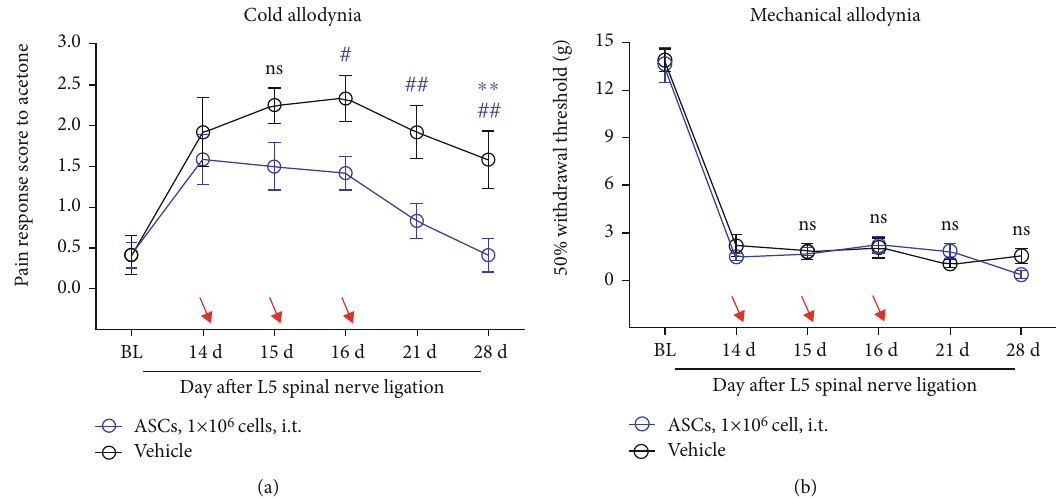
Figure 3: Intrathecal injection of ASCs speci fi cally reduced cold allodynia in L5 spinal nerve ligation models. (a, b) Intrathecal injection of ASCs ( 1 × 10 6 cells in 30 μ l DMEM) had an analgesic e ff ect on cold allodynia (a) but not mechanical allodynia (b), administered 14 days after L5 spinal nerve ligation. # p < 0 : 05 , ## p < 0 : 01 , ### p < 0 : 001 , compared with vehicle (DMEM; 30 μ l); ∗ p < 0 : 05 , compared with POD14; n = 6 rats/group. Arrows indicate time of injection (POD 14, POD 15, POD 16). All data are expressed as the mean ± SEM . Statistical signi fi cance was determined by 2-way ANOVA, followed by Sidak ’ s posthoc test. POD: postoperative day; BL: baseline; i.t. : intrathecal injection; ASC: adipose tissue-derived stem cell; DMEM: Dulbecco ’ s modi fi ed Eagle ’ s high-glucose